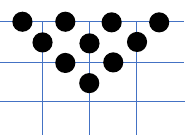
FIG. 7. A set of qubits O such that each orbit of R contains exactly one qubit from O . In this example, the group R has ten orbits of size 1, 2, and